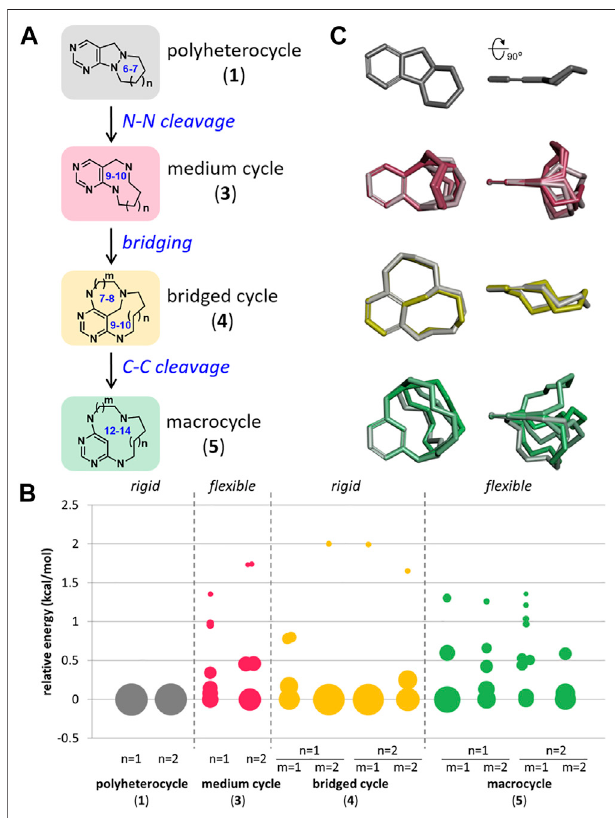
FIGURE 2 | Design strategy for pyrimidine-embedded medium/macro- and bridged cyclic scaffolds. (A) Overview of skeletal transformation strategy. (B) Conformational analysis of all designed scaffolds. (C) Overlay of the selected conformers of representative scaffolds aligned by pyrimidine